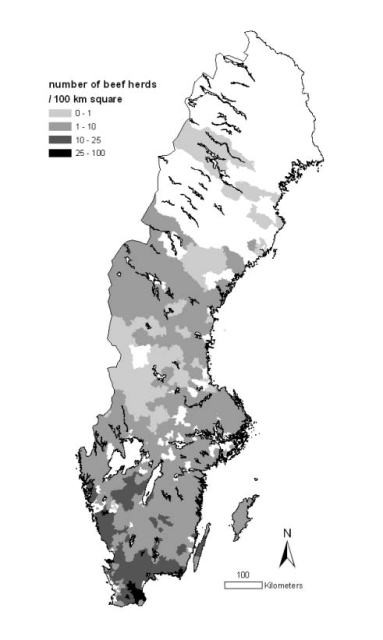
The population of Swedish beef herds presented as density by three-digit postal code area (2007). © Lantmäteriverket Gävle 2010. Permission number I 2010/0055.